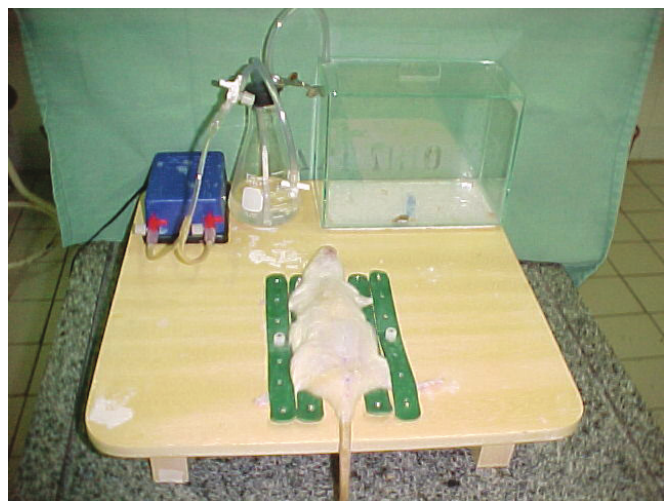
FIGURE 3 - Animal placed on the surgical table using rubber